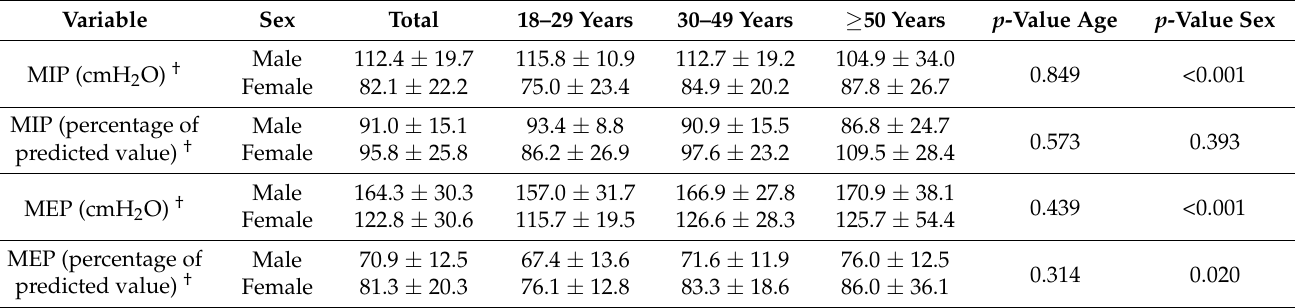
Table 5. Respiratory muscle strength: